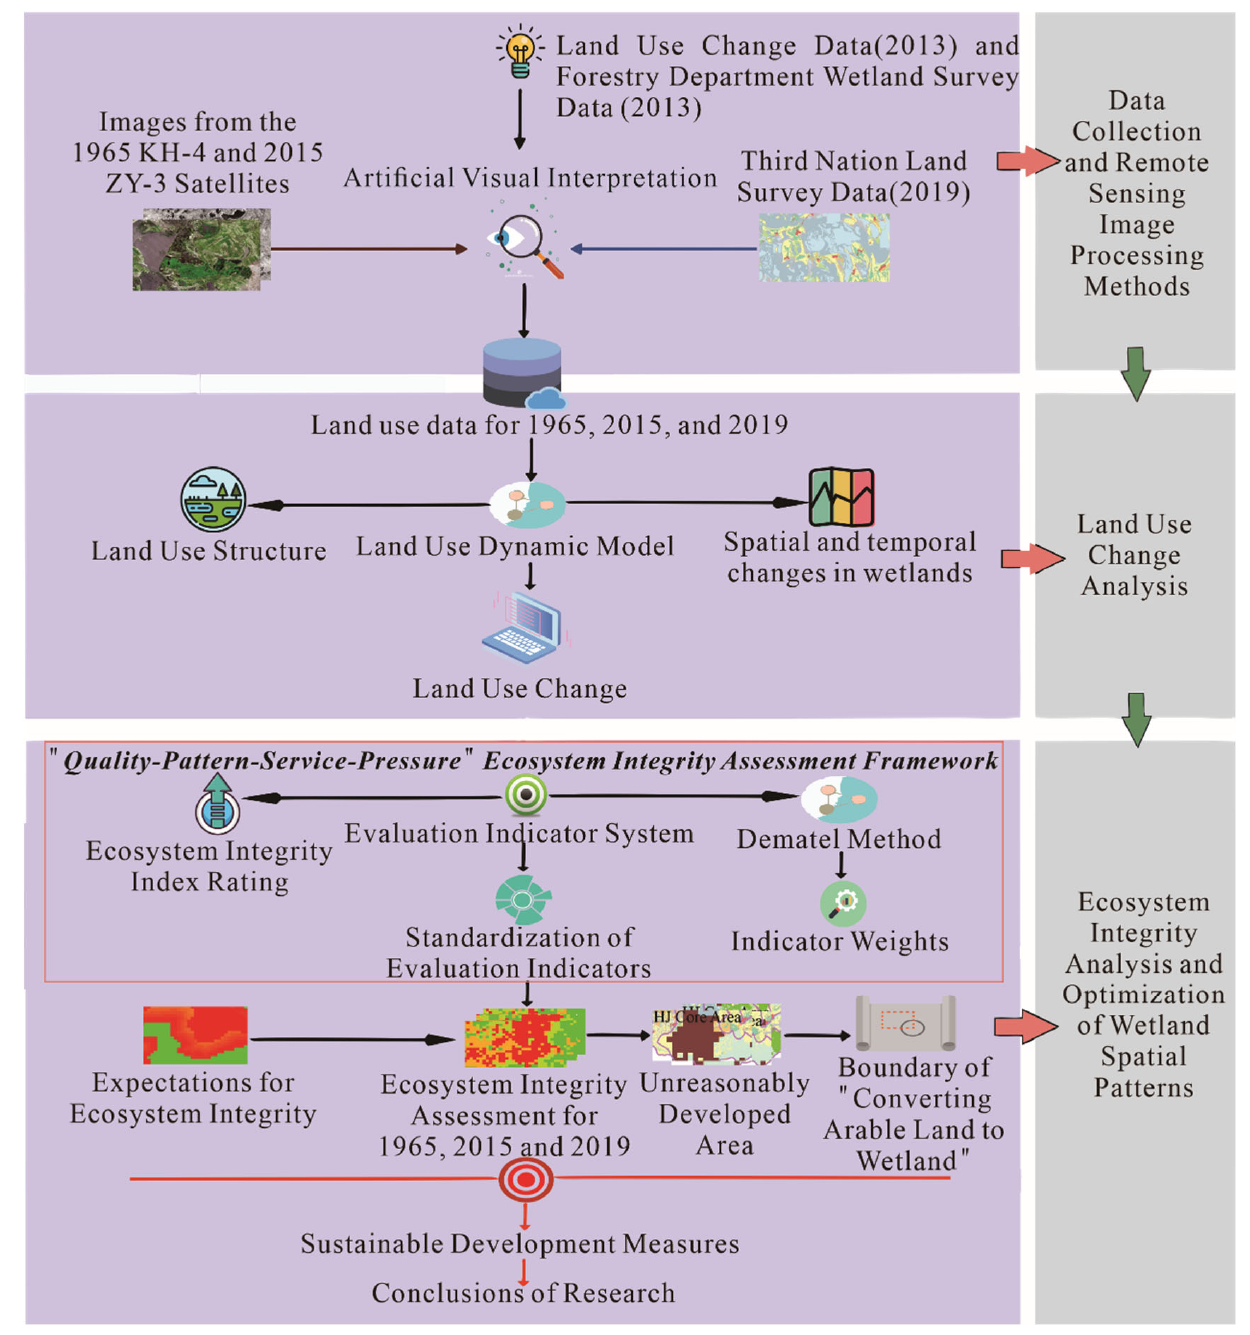
Figure 2. Flowchart of the study.